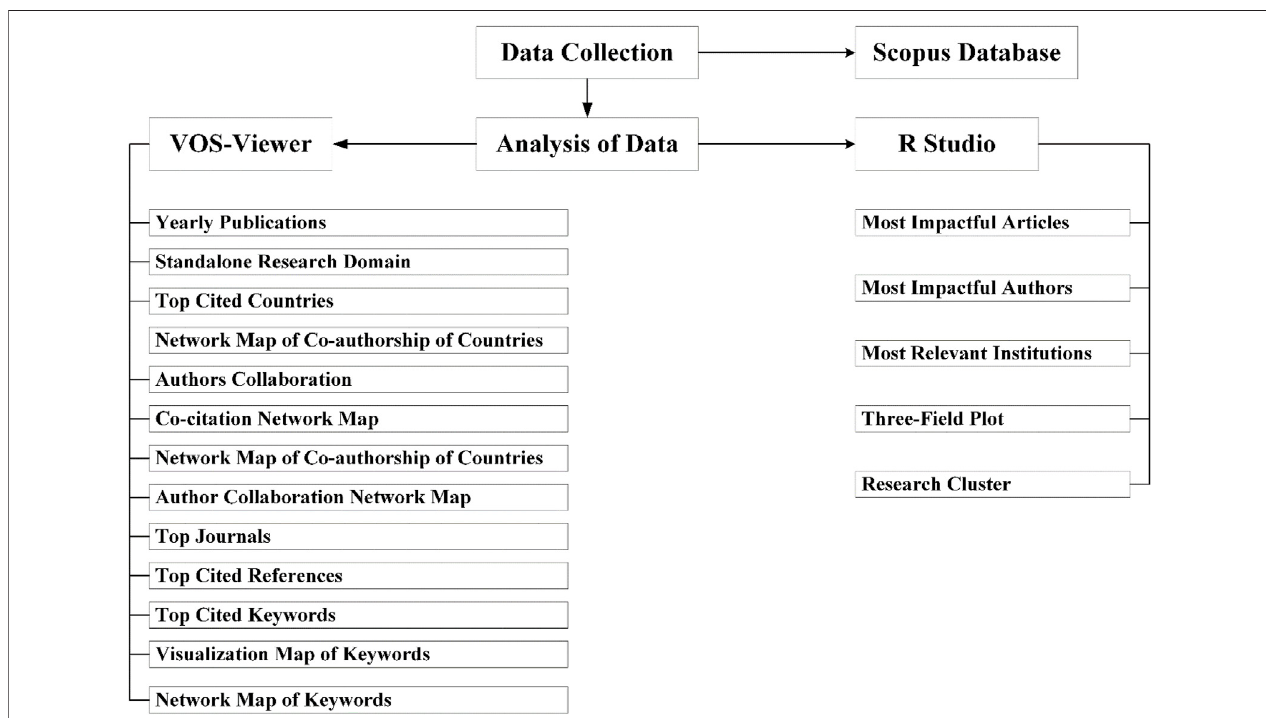
FIGURE 1 | Process of research